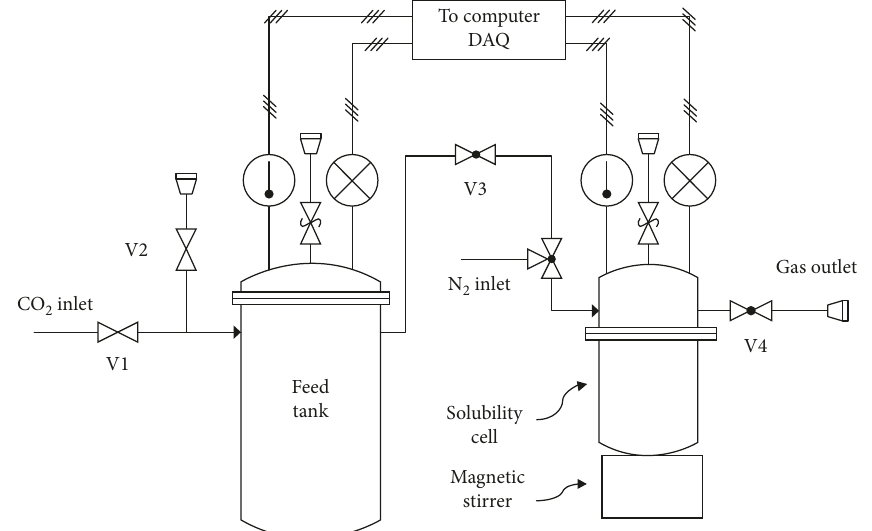
Figure 1: Pressurized reactor